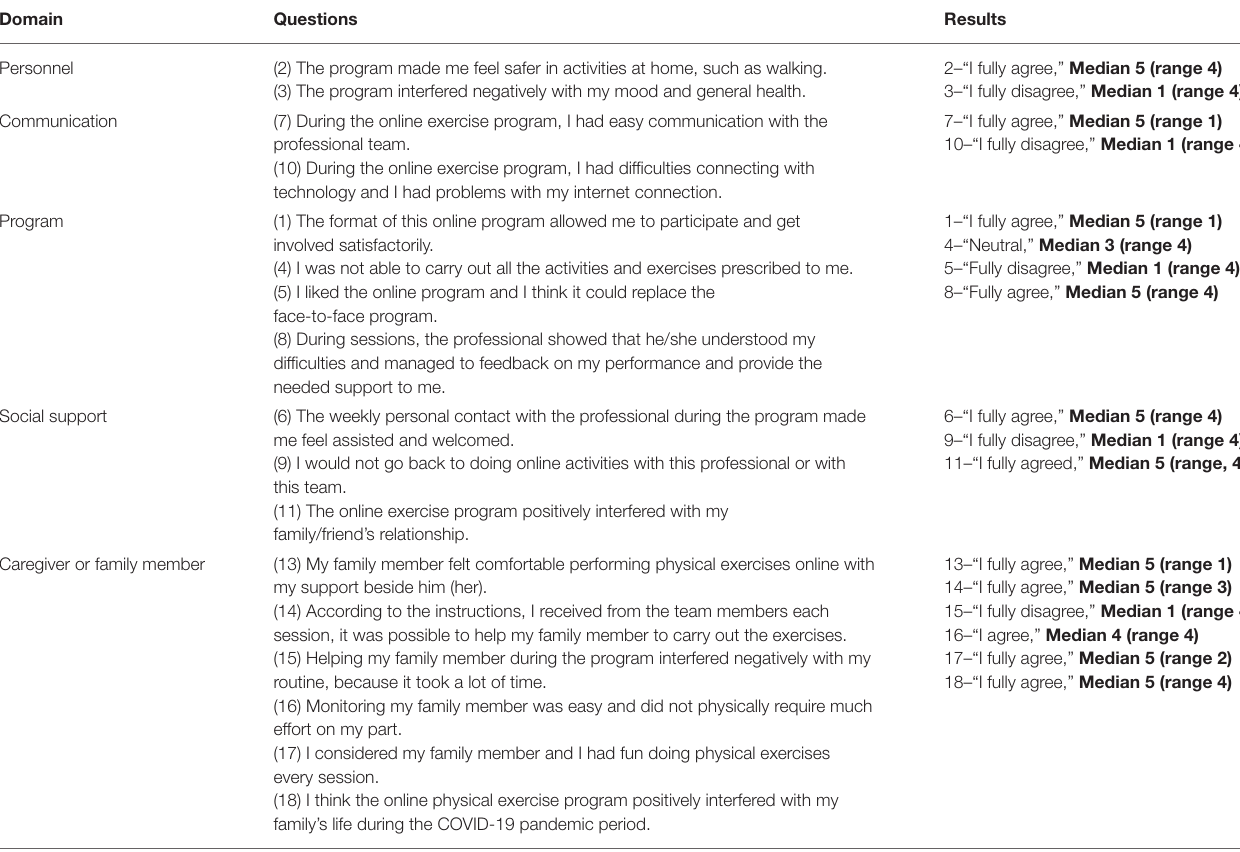
TABLE 5 | Median and range results across the answers of all the participants for the overall experience questionnaire.